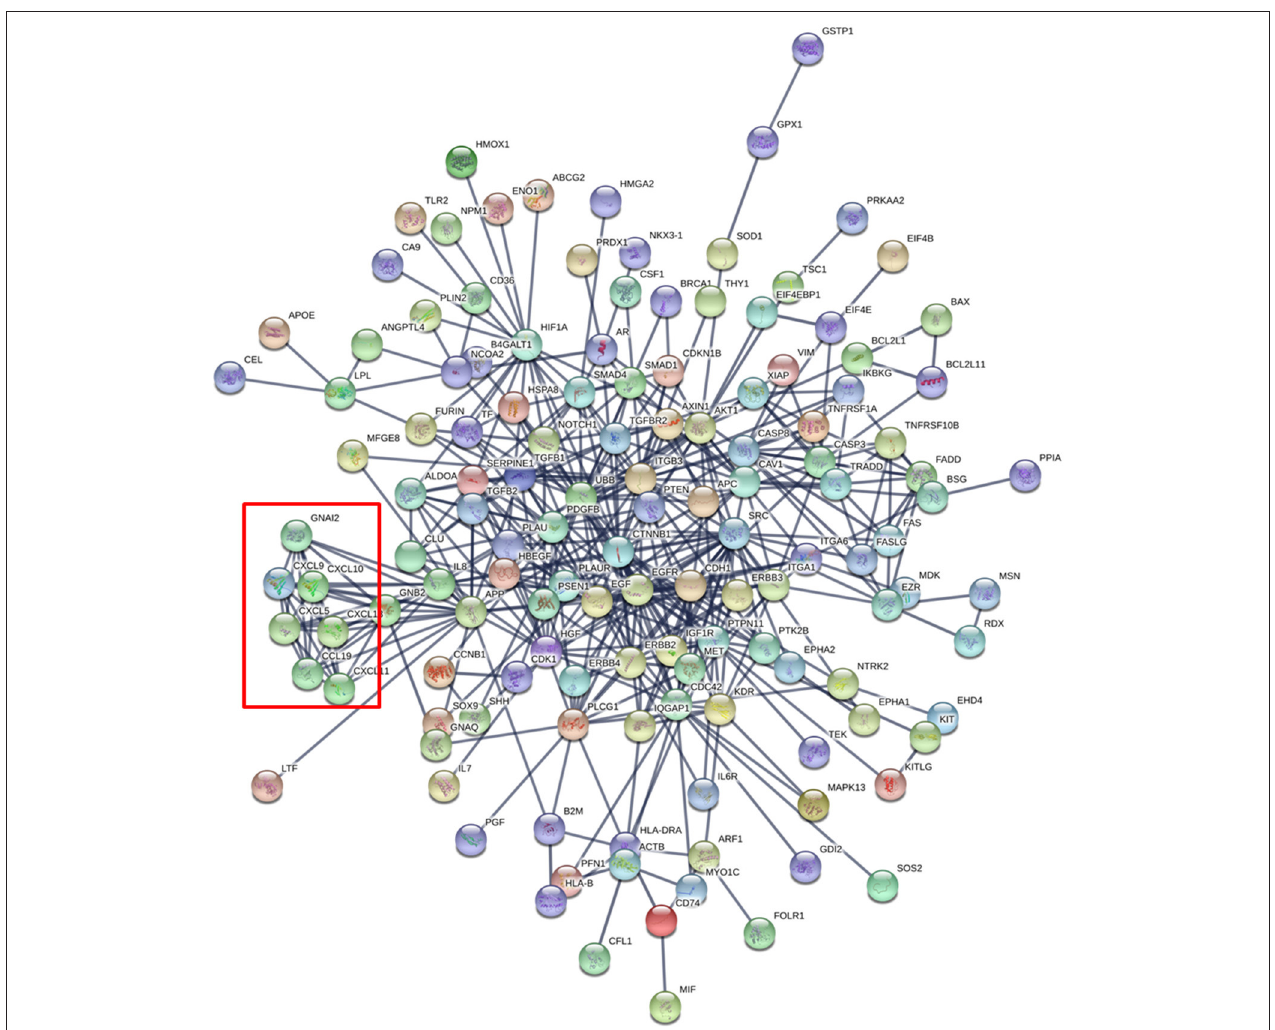
FIGURE 2 | Protein Network generated with the 188 proteins identified in the combined human breast milk exosome proteomics dataset (Admyre et al.,; Larssen et al.). The red square shows a cluster of